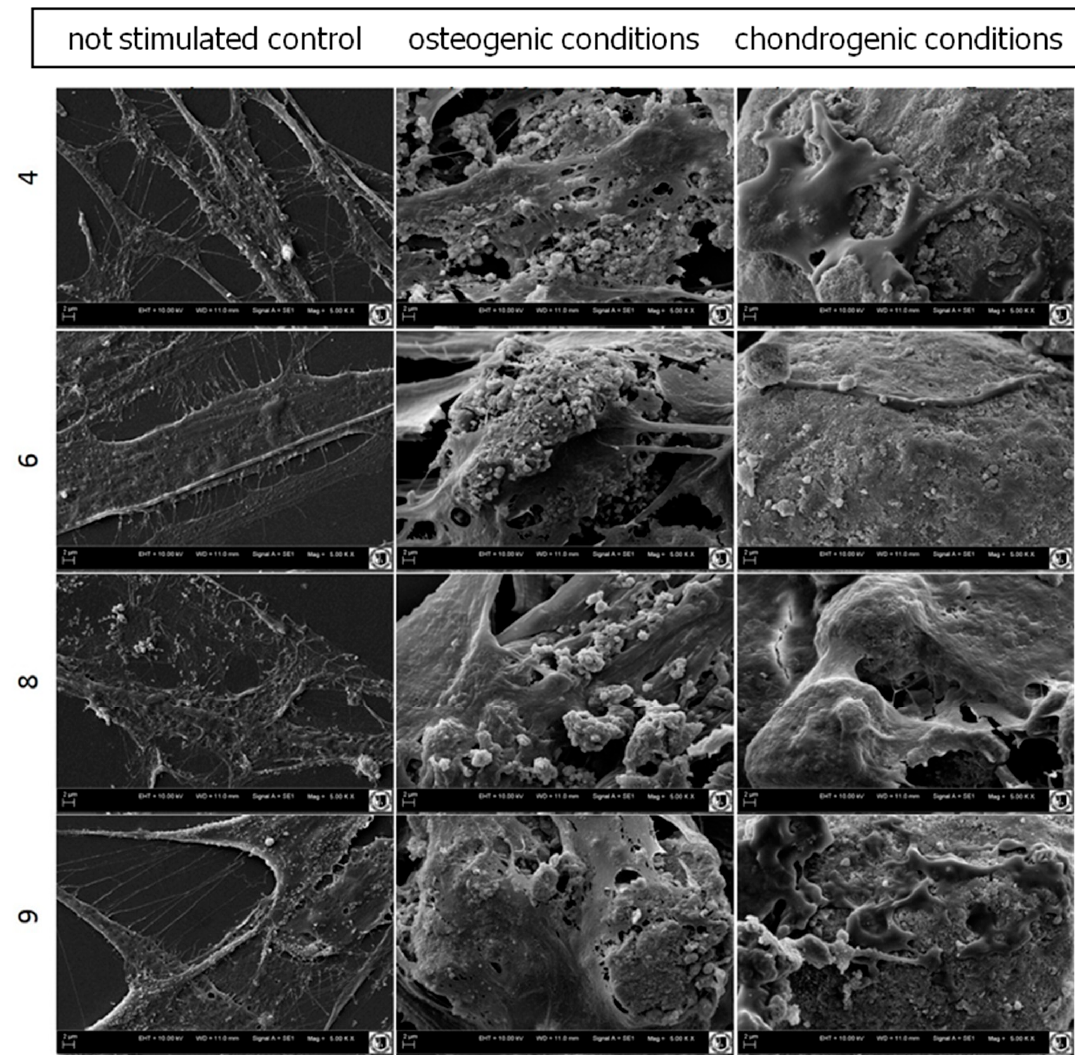
Figure 11. Scanning electron micrographs presenting cells cultured on each biomaterial (4, 6, 8, 9—rows, described in Table 3) at different culture conditions (columns); mag. 5000×, scale bars indicated on micrographs.